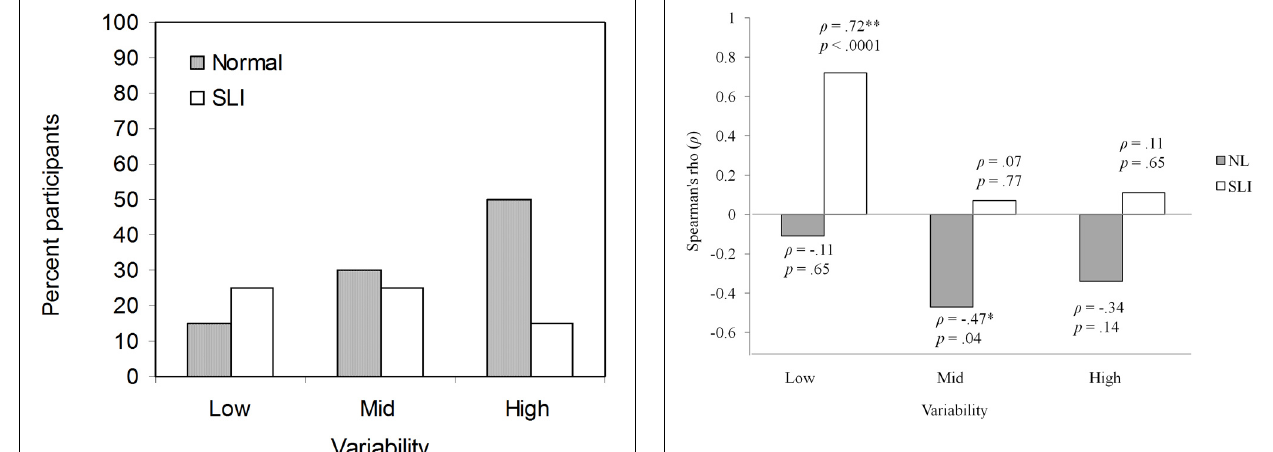
FIGURE 4 | Correlations between number of pairs learned and language ability for the pal1icipants with SLI in the low, mid, and high variability